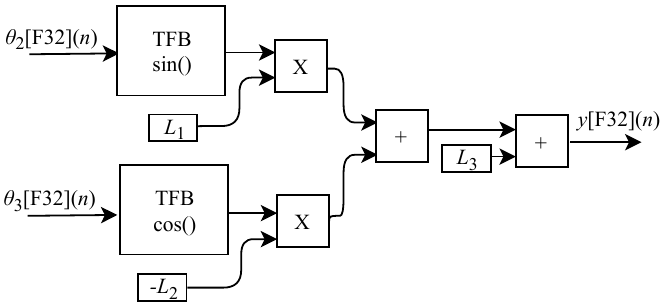
Figure 7. Proposed forward kinematics circuit for obtaining the y [ F 32 ]( n ) spatial coordinate (Equation (16))—FK-HMD and